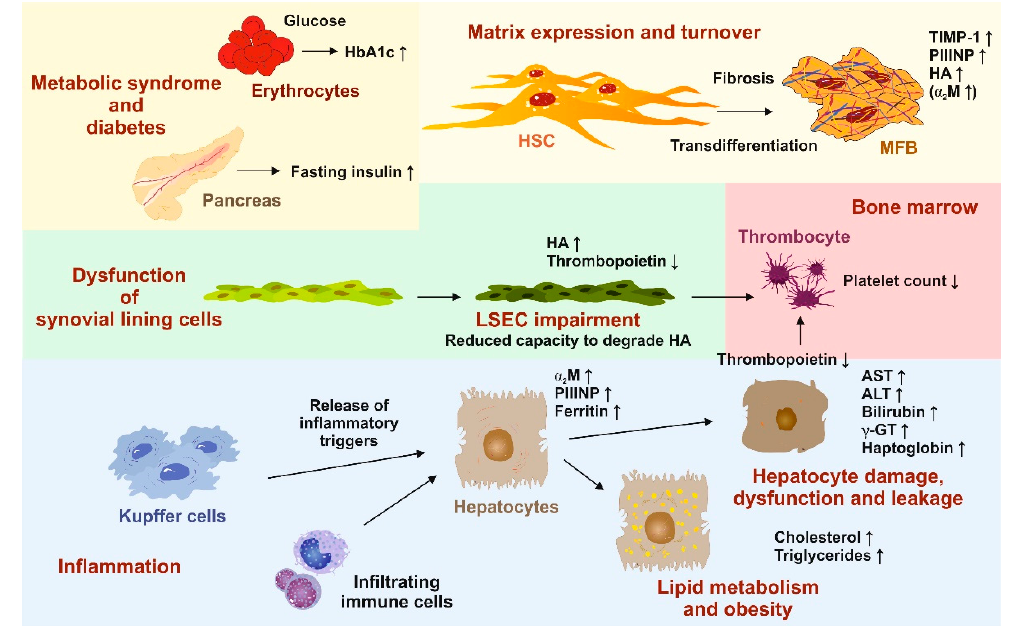
Figure 3. Significance of laboratory parameters in the diagnosis NAFLD and NASH. In the scheme, the biological source and alteration of individual biochemical markers during progression of NAFLD/NASH are indicated. High caloric intake and elevated quantities of fat result in hepatic steatosis, triggering steatohepatitis. The inflammatory response is triggered by infiltrating immune cells and liver-resident Kupffer cells releasing a plenitude of inflammatory triggers. As a consequence, the expression of acute phase response proteins ( α 2 macroglobulin ( α 2 M) and ferritin) is increased in hepatocytes. In addition, the increase of cholesterol and triglycerides provokes cellular fat accumulation, damage, and cellular leakage of hepatocytes. This is indicated by elevated quantities of aspartate aminotransferase (AST), alanine aminotransferase (ALT), bilirubin, and γ -glutamyltransferase ( γ -GT). Subsequently, the overall capacity of these cells to synthesize typical liver proteins (haptoglobuin, thrombopoietin) decreases. Lower quantities of thrombopoietin results in reduced formation of platelets within the bones. Dysfunction of synovial lining cells (reduced capacity to degrade hyaluronic acid (HA)) and ongoing fibrogenesis lead to elevated levels of HA. In addition, the transdifferentiation of hepatic stellate cells (HSC) to myofibroblast (MFB) is associated with the occurrence of typical biomarkers (tissue inhibitor of matrix metalloproteinase-1 (TIMP-1), amino-terminal propeptide of type III procollagen (PIIINP)), which correlate to extracellular matrix formation and/or turnover. The metabolic syndrome associated with NAFLD/NASH results in higher quantities of fasting insulin and basal glucose triggering the non-enzymatic formation of glycated hemoglobin (HbA1c). All these parameters are diagnostically relevant in the diagnosis or scoring of NAFLD/NASH and are the basis of various blood biomarker panels to identify inflammatory liver disease.